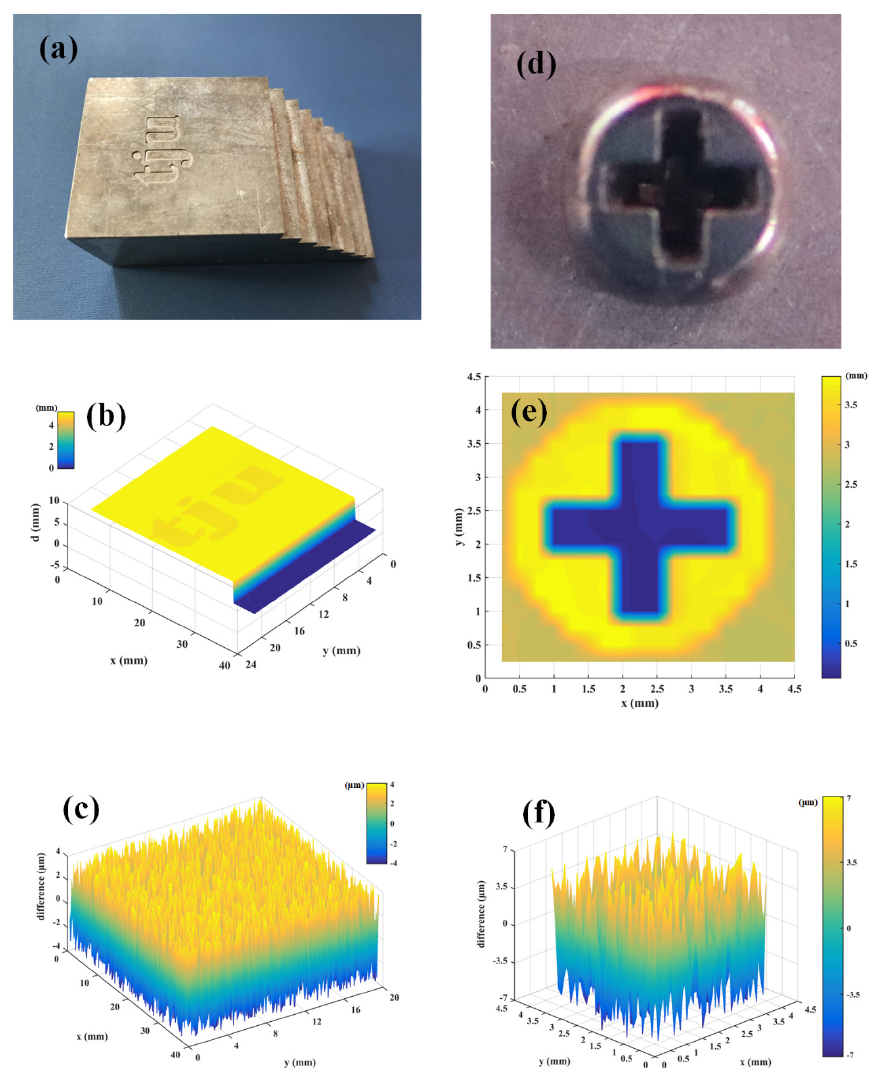
Figure 4. Experimental results of three-dimensional imaging. ( a ) Photograph of the customized specimen; ( b ) Reconstructed image based on the point cloud. We find that the “tju” letters can be clearly resolved; ( c ) Difference between our measurement results and the reference values; ( d ) Photograph of the screw specimen; ( e ) Reconstructed image based on the point cloud. The cross hole can be measured clearly; ( f ) Difference between our measurement results and the reference values, for the screw.